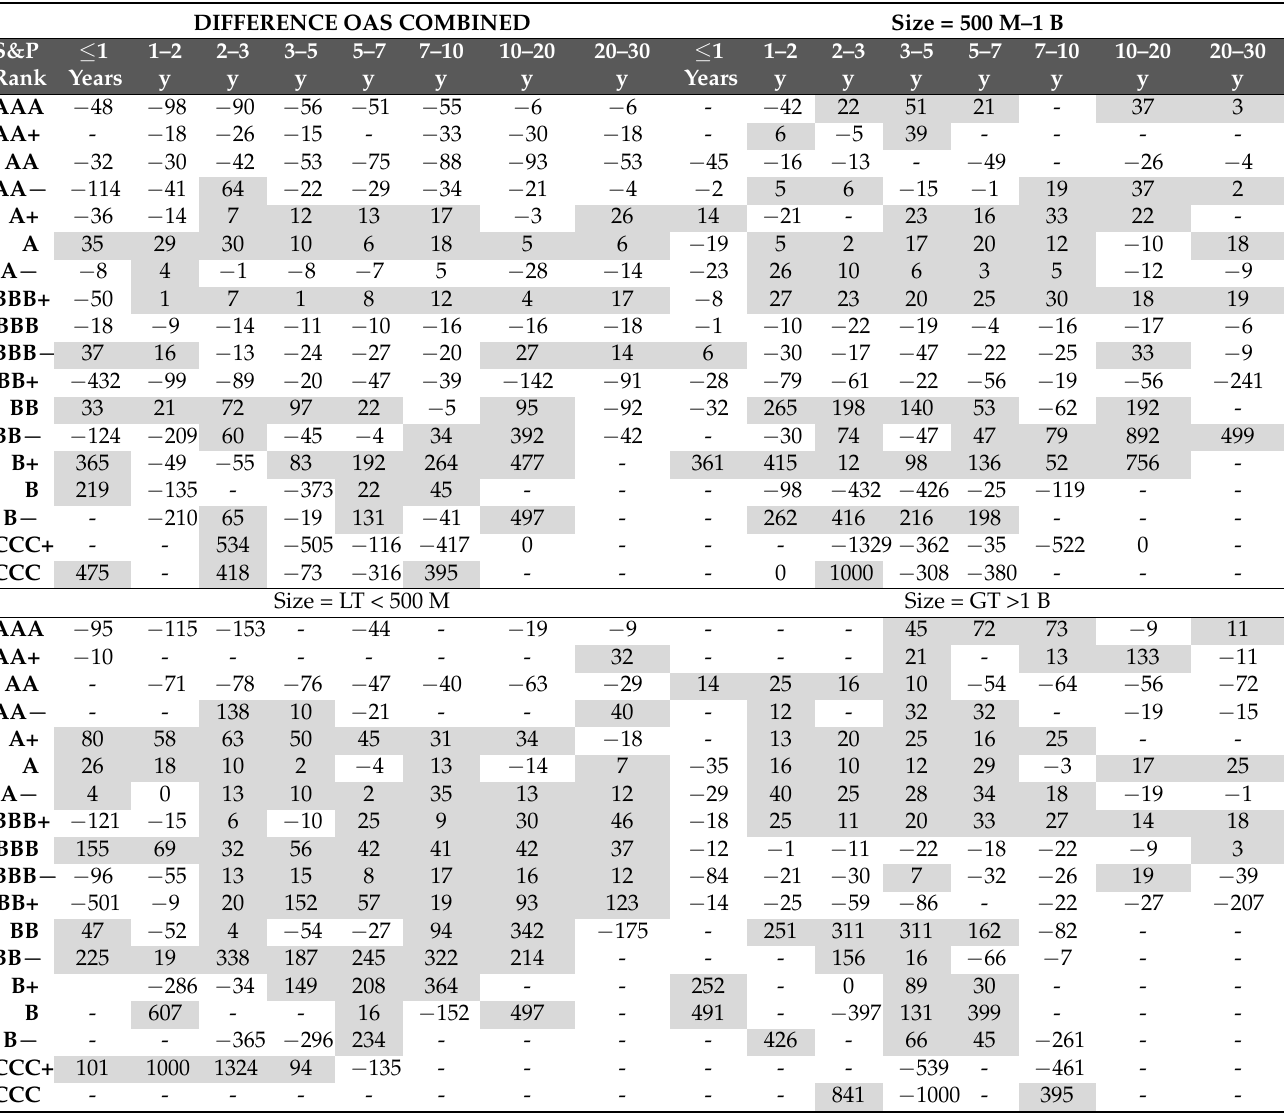
Table A3. The table shows the average cell-based option-adjusted spreads’ differences for U.S. operating and holding companies, using S&P ranking and matching Treasury maturities. Cell values are averages in basis points for the bonds included in the cell. The U.S. holding companies’ cell values are in basis points (computed using Bloomberg—Fixed Income Worksheets, accessed on 26 September